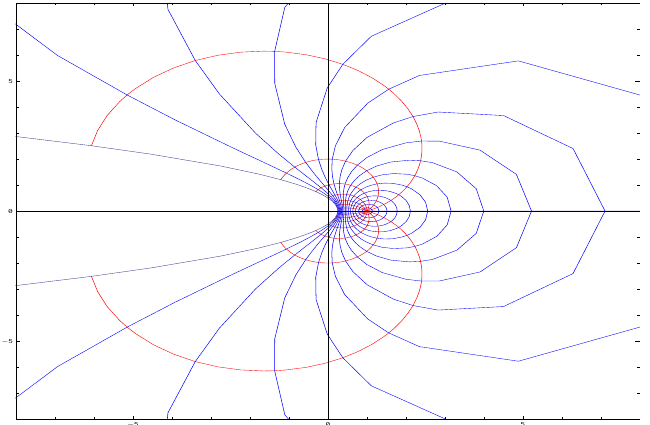
(cid:2) π (cid:3) , π ; p ( z ) if p ( z ) = 1 + z /1 − z 2 2